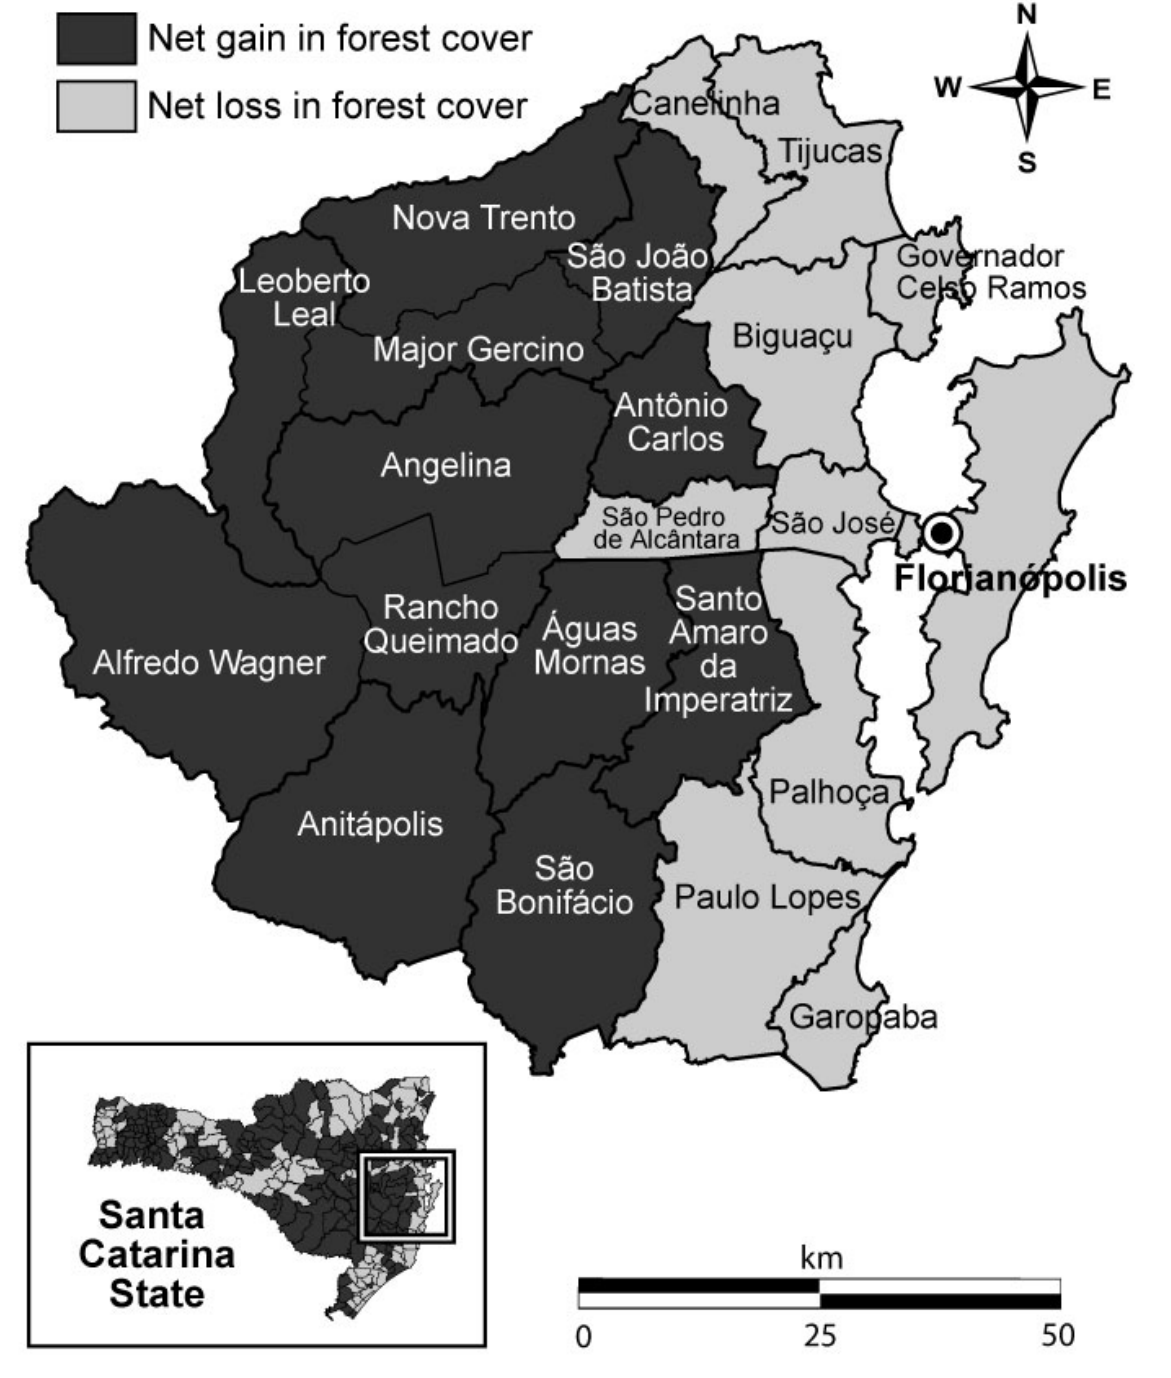
Fig. 7. Gains and losses in private forest cover in the Florianópolis metropolitan region from 1985